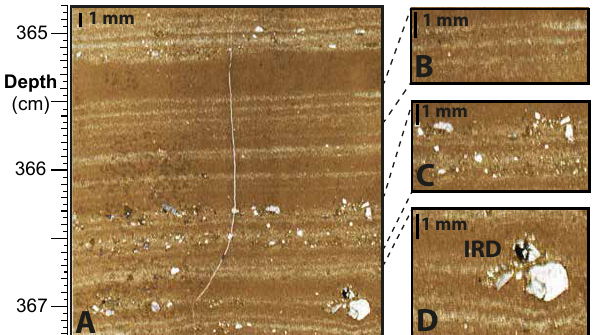
Fig. 3. Detailed images of a scanned thin section of PS1795. A gives an overview of the 2 Figure 3. Detailed images of a scanned thin section of PS1795. varved sediment and the thickness variation of lighter, coarser-grained and darker, finer-3 (A) gives an overview of the varved sediment and the thickness grained layers. On the right side are three zoomed-in photos: typical varves (B); sand-rich 4 variation of lighter, coarser-grained and darker, finer-grained lay- lighter coarser-grained layers with some ice-rafted debris (IRD) (C); D shows some individual 5 ers. On the right are three close-up photos: typical varves (B) ; sand- large IRD, deposited by deforming the sediment below. 6 rich lighter coarser-grained layers with some ice-rafted debris (IRD) (C) ; (D) shows some individual large IRD, deposited by deforming the sediment